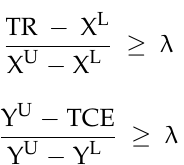
Table 15. Economic potential and environment impact in scenario 3.